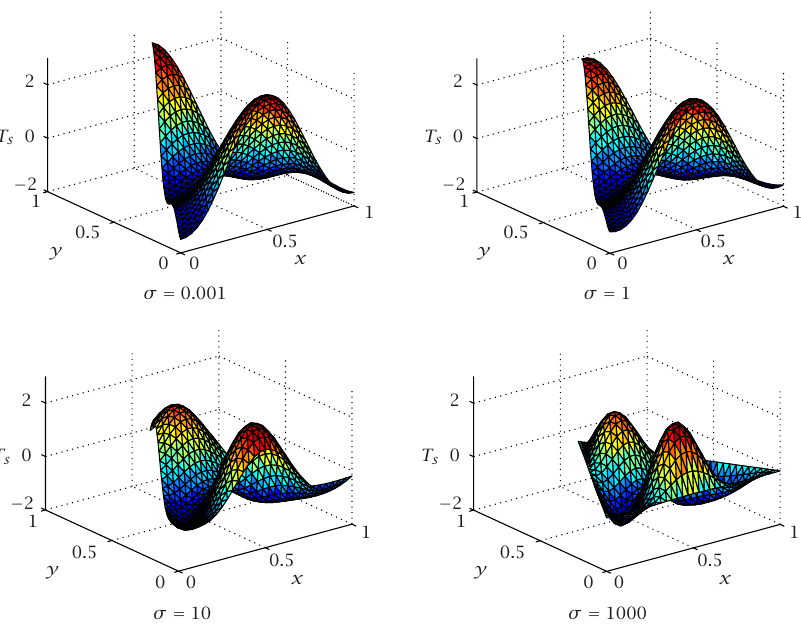
Figure 7.2 . The ( 0 , 2 ) symmetric mode.